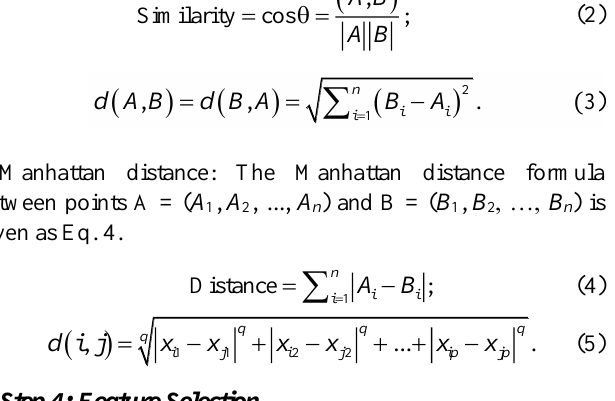
Fig. 3. Search space of